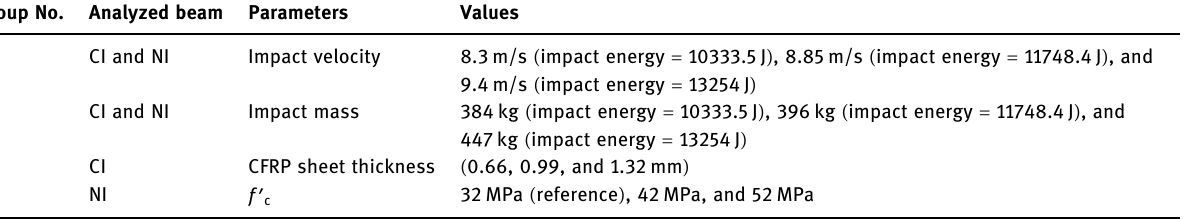
Table 5: Details of the adopted parametric analysis Group No. Analyzed beam Parameters